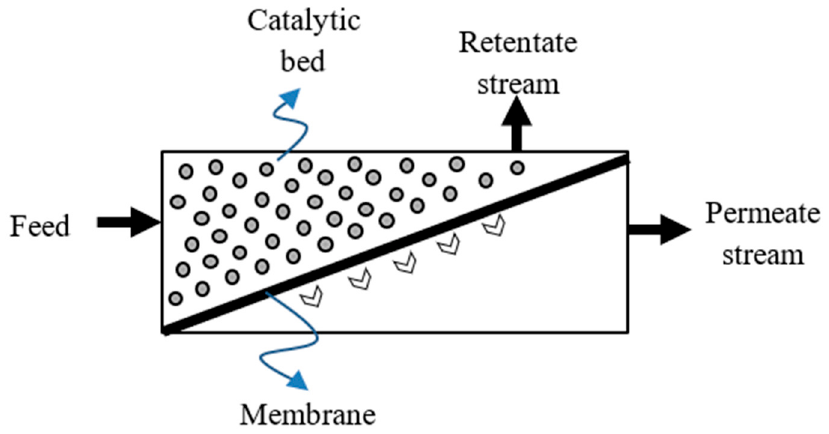
Figure 1. Conceptual scheme of a membrane reactor (MR) system.